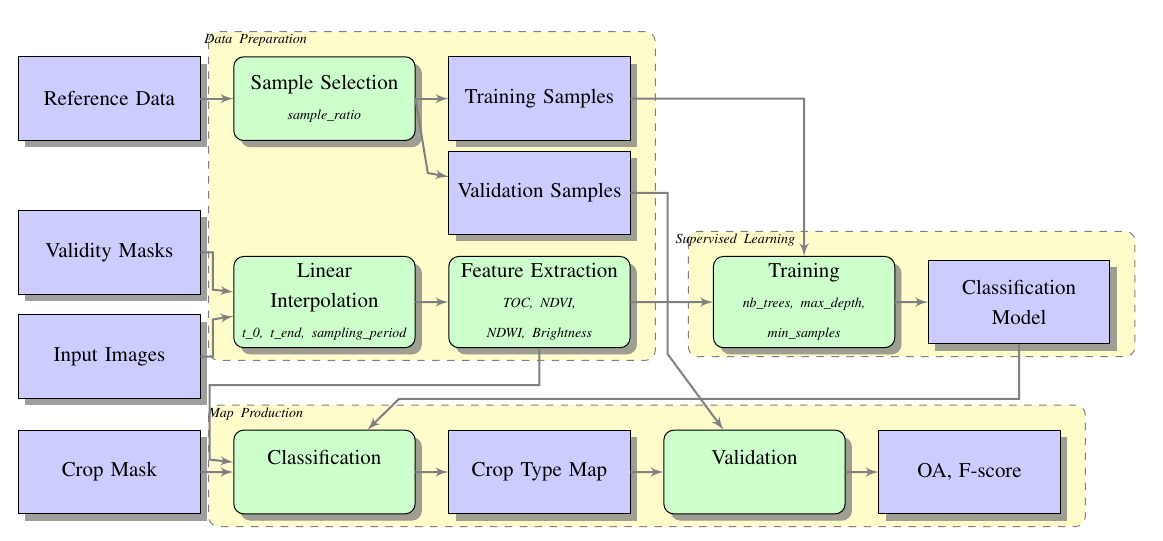
Figure 3. Block diagram of the crop type map